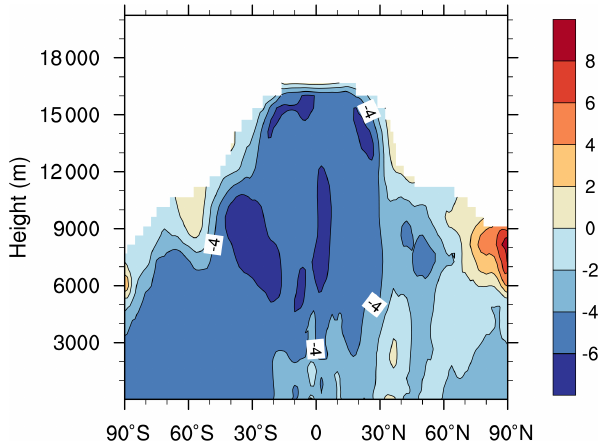
Figure 18. The difference between the zonal total annual-mean tro- pospheric CO (ppbv) modelled using the new lightning flash-rate parameterisations (Run 2) and the default PR92 parameterisations (Run